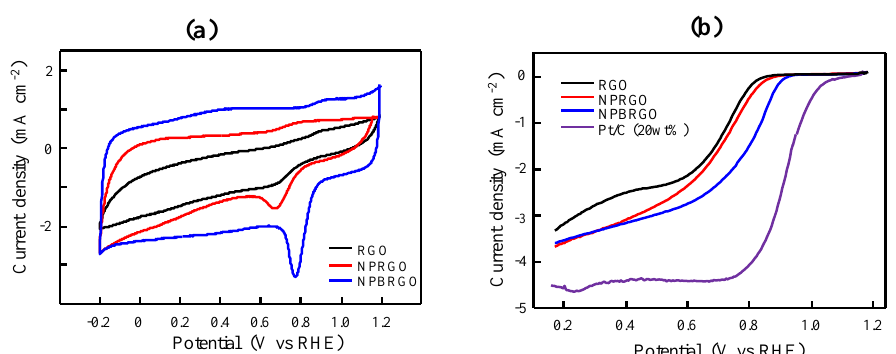
Figure 4. ( a ) Cyclic voltammograms of RGO, NPRGO, and NPBGRO using a scan rate of 50 mV/s in an O 2 saturated 0.1 M KOH solution, ( b ) linear sweep voltammograms of RGO, NPRGO, and NPBRGO (reference = Pt/C (20 wt.%)) using a rotational speed of 1600 rpm.